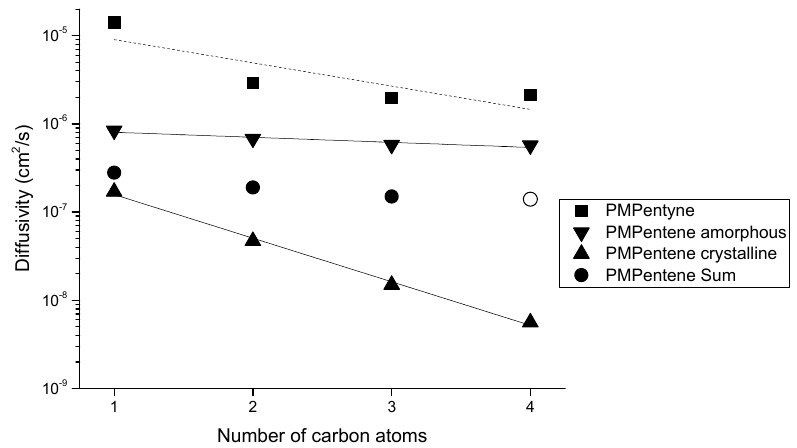
80 °C: experimental data; , data calculated using two-phase model (Equations (2) and (3)); extrapolated from experimental data; (cid:3) , data calculated using correlation approach (Equations (7)–(9)). extrapolated from experimental data; , data calculated using correlation approach (Equations (7)–(9)). (cid:35)